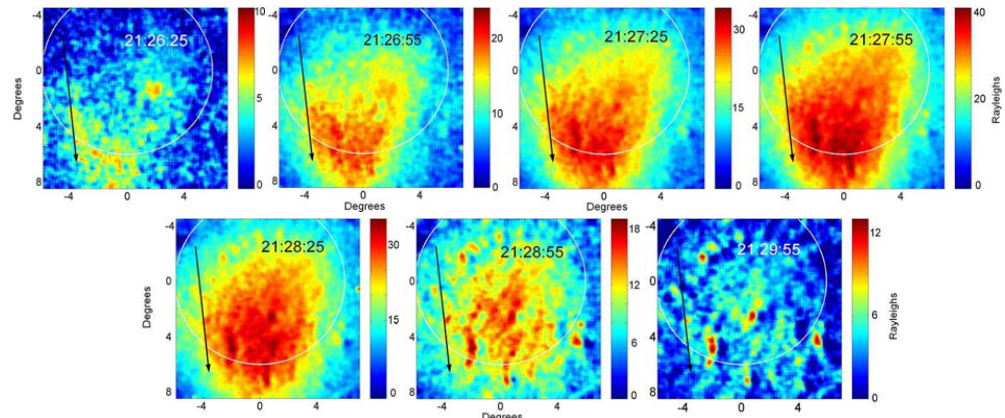
Fig. 2. A sequence of images showing the development and decay of the 630-nm artificial airglow patch during one HF pumping cycle obtained at 21:26–21:30 LT on 15 September 2004. The integration time is 27s, the end time of the integration is shown in the panels. The images are background subtracted and calibrated into Rayleighs. The background image was recorded at 21:25:55 LT. North and east are at the bottom and right of each image. The white circle is a mapping of the 12 ◦ wide HF pump beam. The black arrows show the direction of Figure 2 for the paper by Grach et al. “On the location and structure…” the geomagnetic field